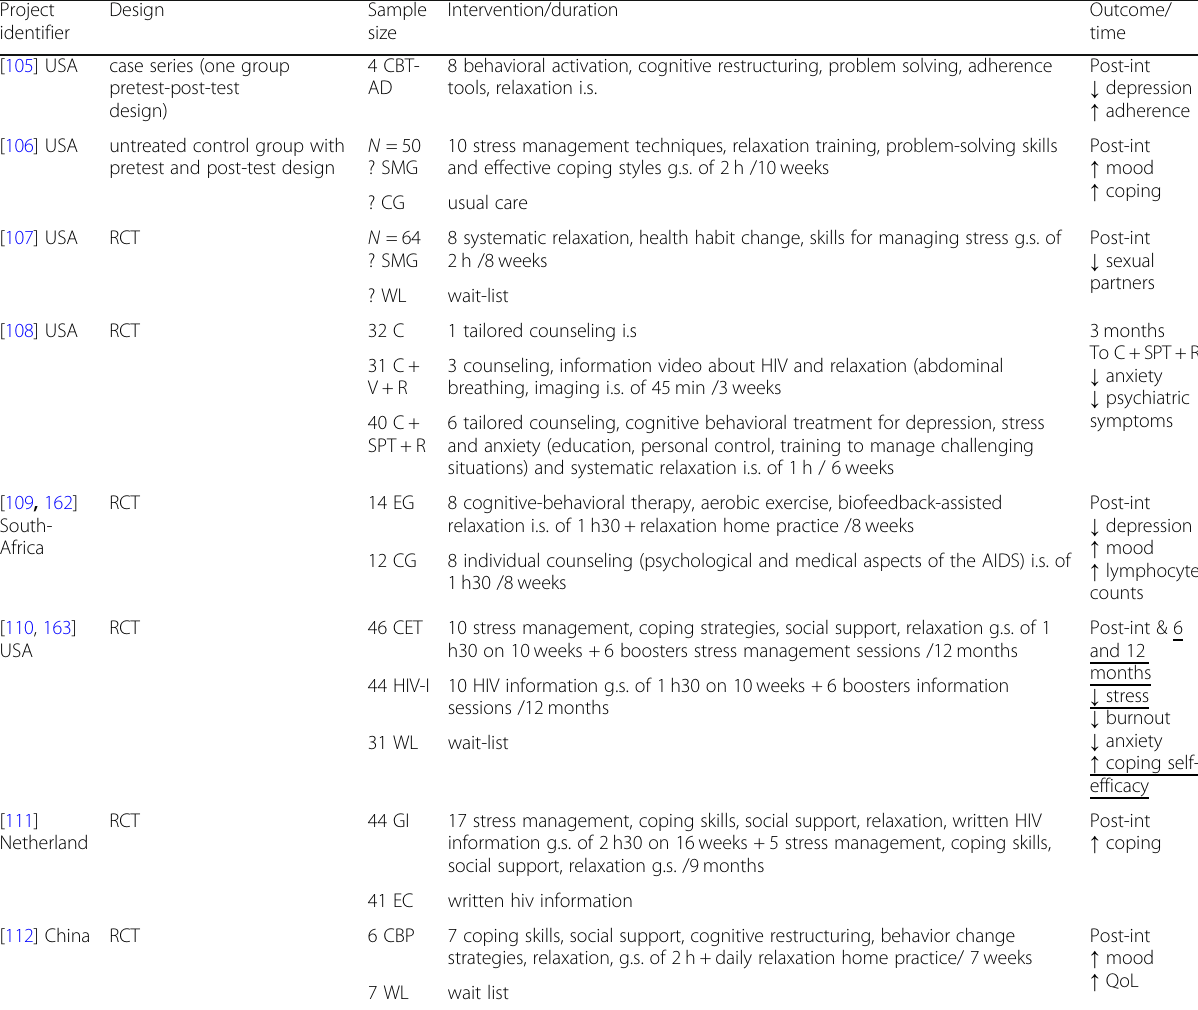
Table 11 Unspecified relaxation included studies Project